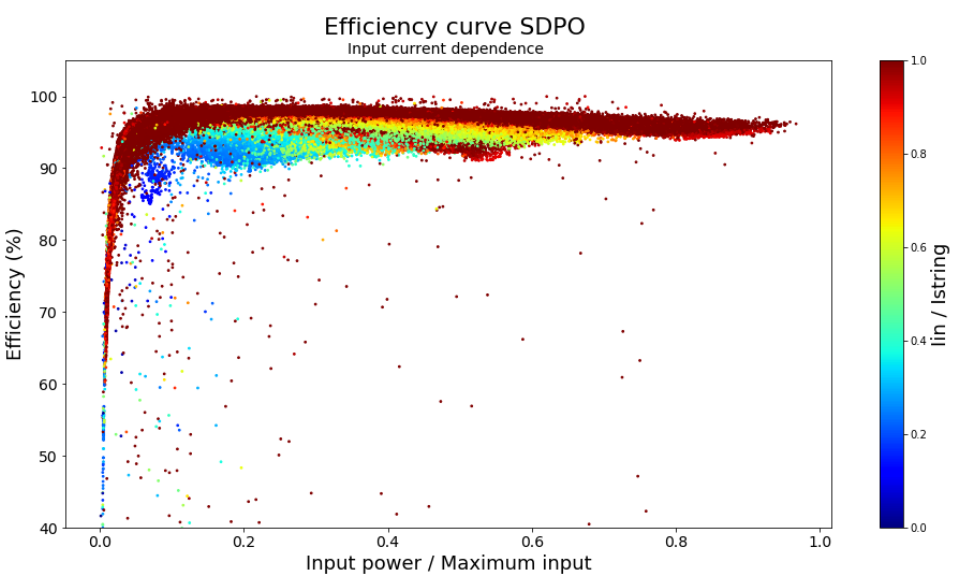
Figure 10. Efficiency dependence of SDPO on input current. Table 1. SDPO efficiency calculations for different Iin/Istring.